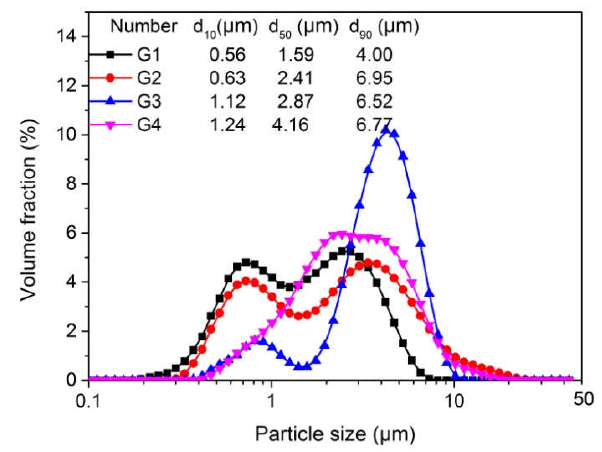
Figure 4. The particle size distribution and particle size (d 10 , d 50 and d 90 ) of the synthesized polymer particle adhesive.